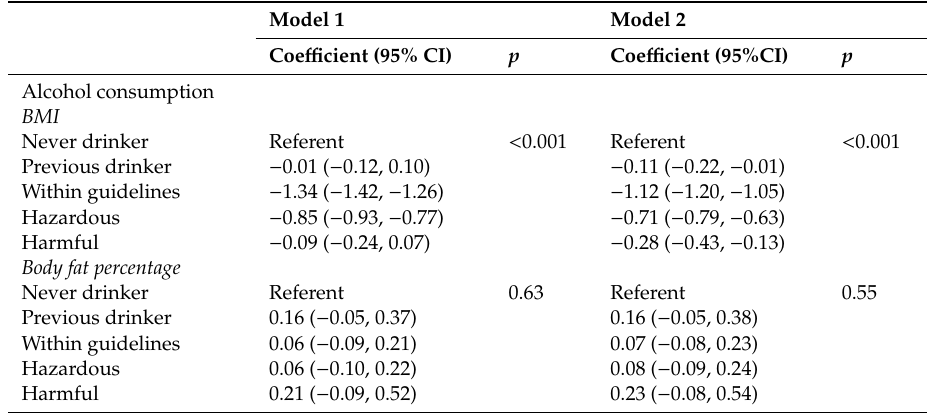
Table 2. Multivariable-adjusted associations between BMI and body fat percentage with alcohol consumption in the UK Biobank ( n =